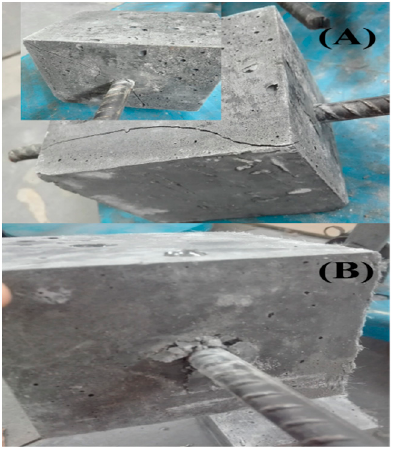
Figure 13. Crack pattern: ( A ) GP0 specimen ( B ) GP5 specimen.